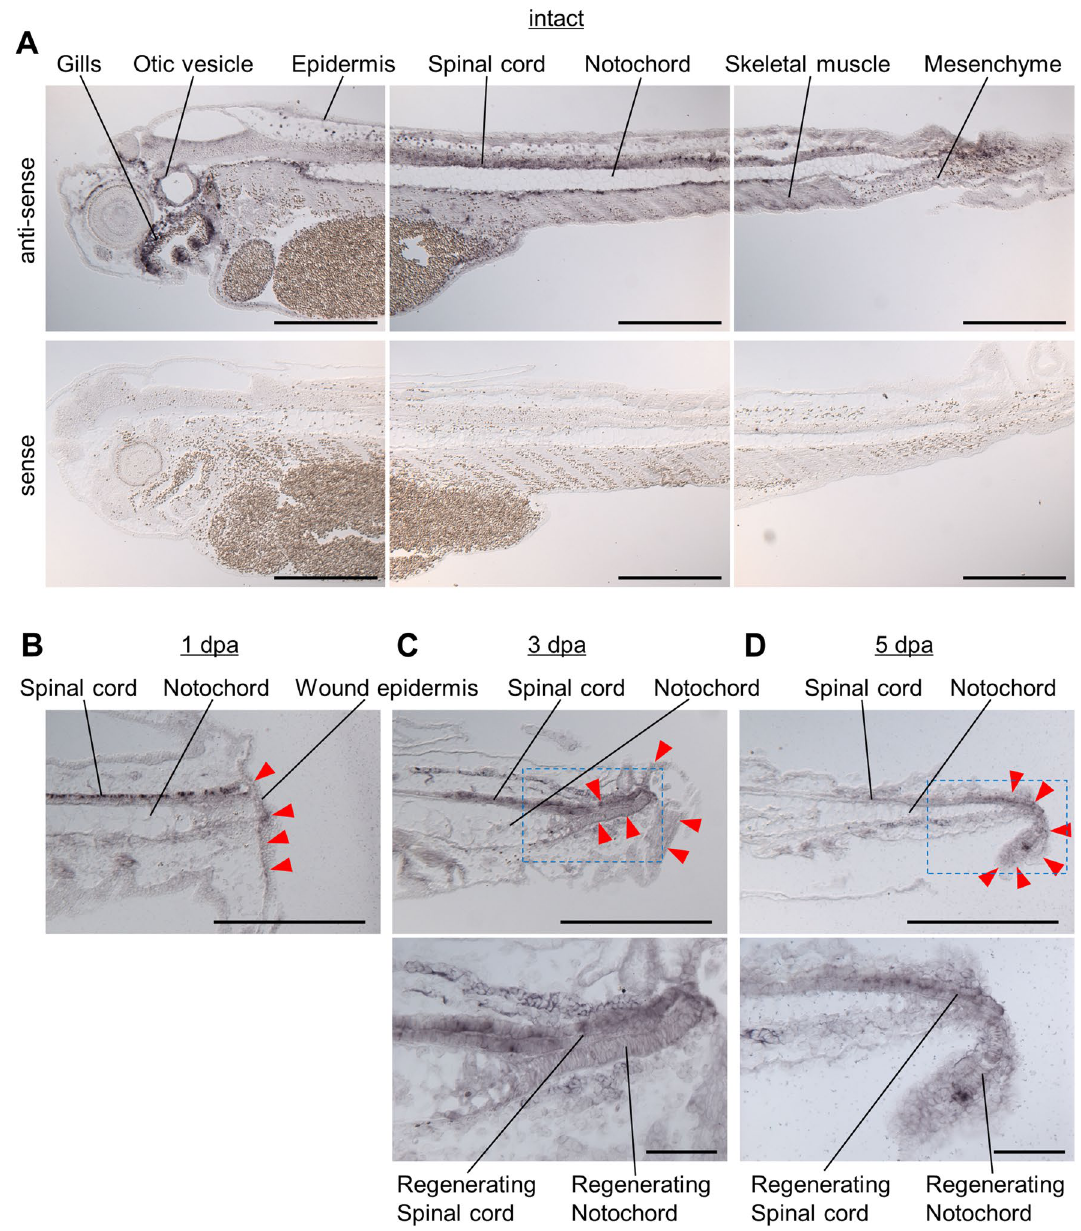
Figure 3. il11ra.L is widely and constitutively expressed in the intact tadpole and regenerating tail. ( A ) In situ hybridization of il11ra.L on a section of intact tadpole (upper) with an antisense probe, and (lower) with a sense probe. Anterior is left and dorsal is up. Scale bars: 500 µm. n = 4. ( B – D ) In situ hybridization of il11ra.L in a section of a regenerating tail. Anterior is left and dorsal is up. Arrowheads indicate notable signals. Scale